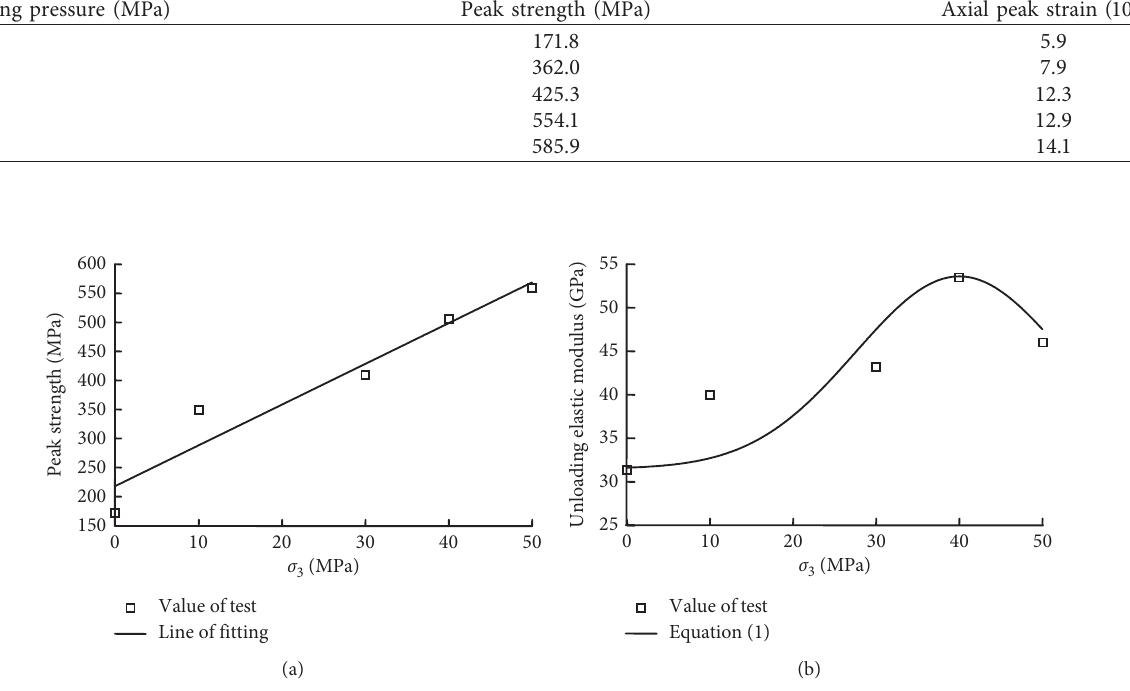
Figure 5: Relationships between peak strength, unloading elastic modulus, Poisson’s ratio, and confining pressure under cyclic loading and unloading. (a) Peak strength vs. confining pressure. (b) Unloading elastic modulus vs. confining